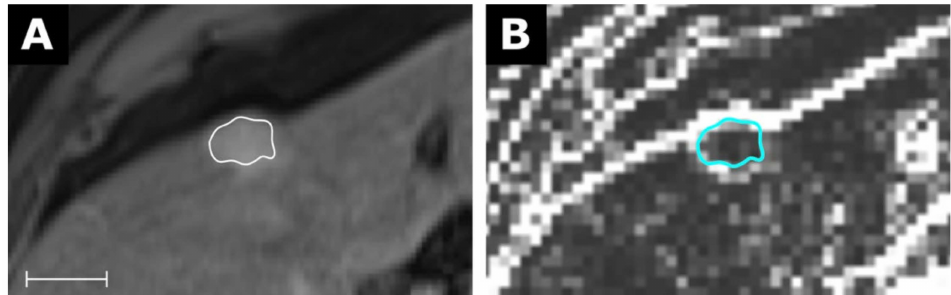
Figure 6. MRI of a hepatocellular carcinoma ( A ) with a corresponding map for the feature Variance with a resolution of 3 × 3 × 3 mm in ( B ). Scale indicates 2 cm. The value for Variance from the conventional extraction was 882 and 108 for the map. Details are available in electronic Table